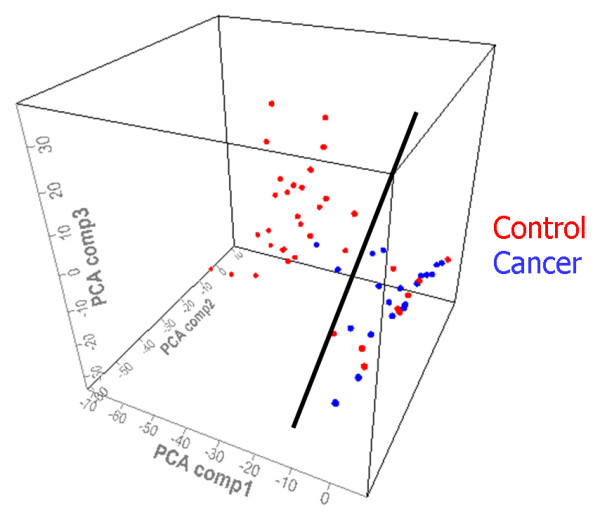
Principal component analysis plot of proteomic features of training set samples. A single plane (denoted by the black line) divides the samples into two groups with 1 false negative (shown in duplicate spots) and 9 false positives.